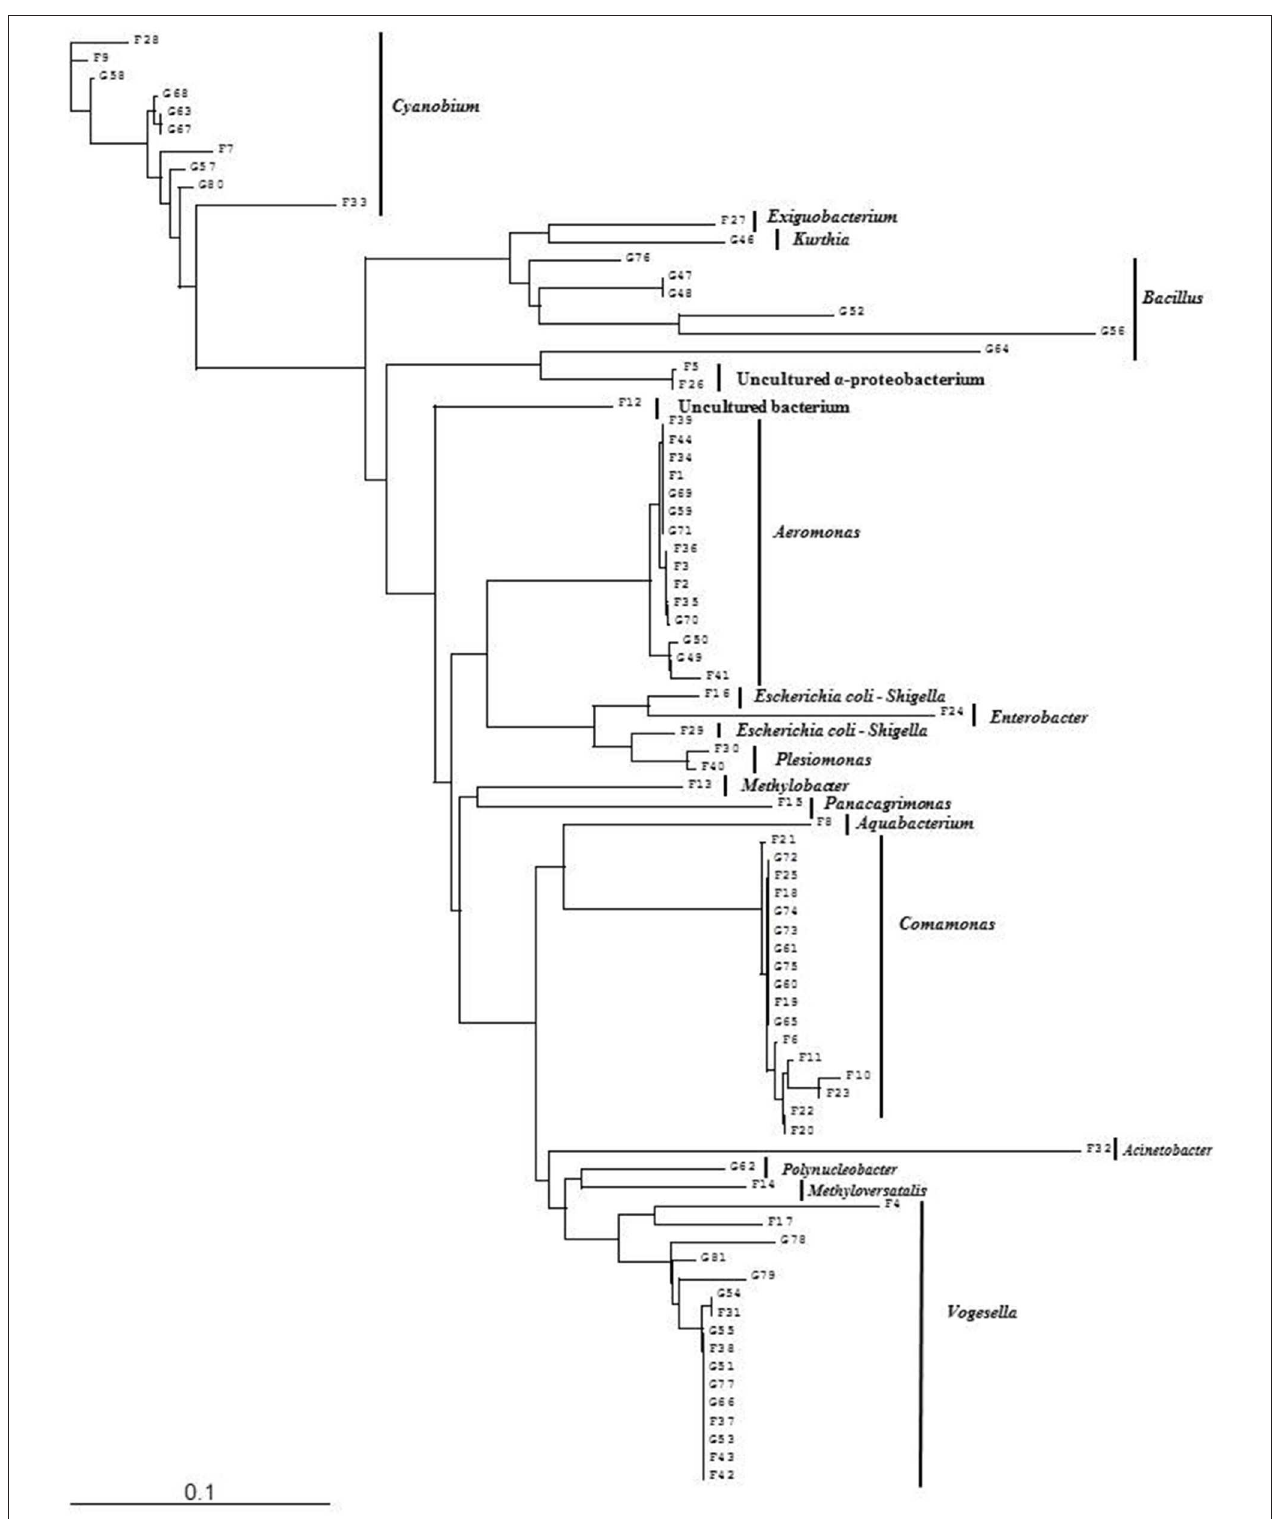
FIGURE 5 | Phylogenetic diversity of bacterial community in Lake Dhanmondi, Dhaka site II based on DGGE (2008–2009). The tree has been rooted with Cyanobium sp.